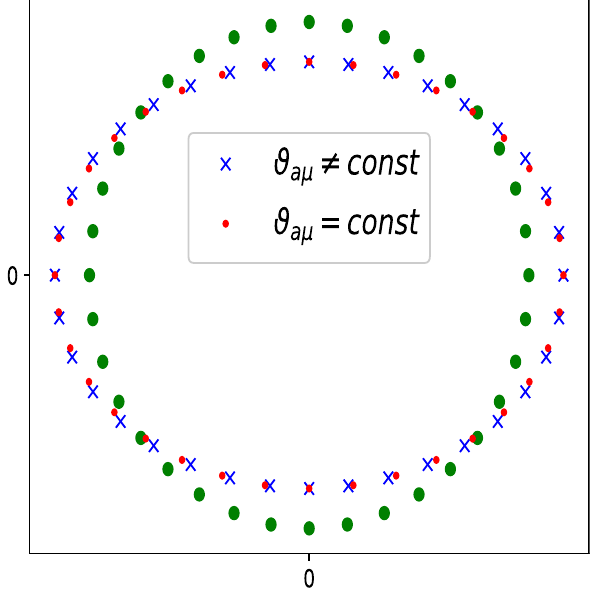
Fig. 1 A ring of masses in presence and absence of GWs